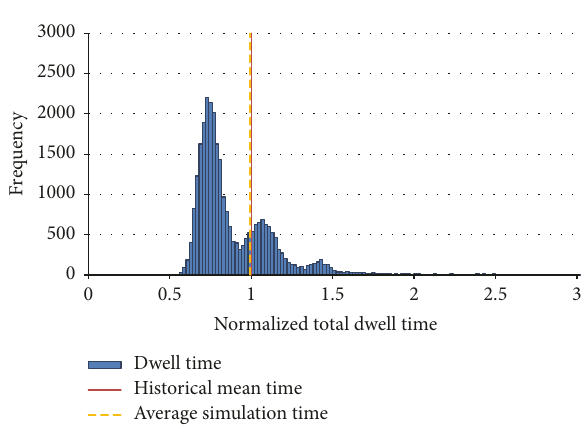
Figure 22: Simulated distribution of total terminal dwell time of